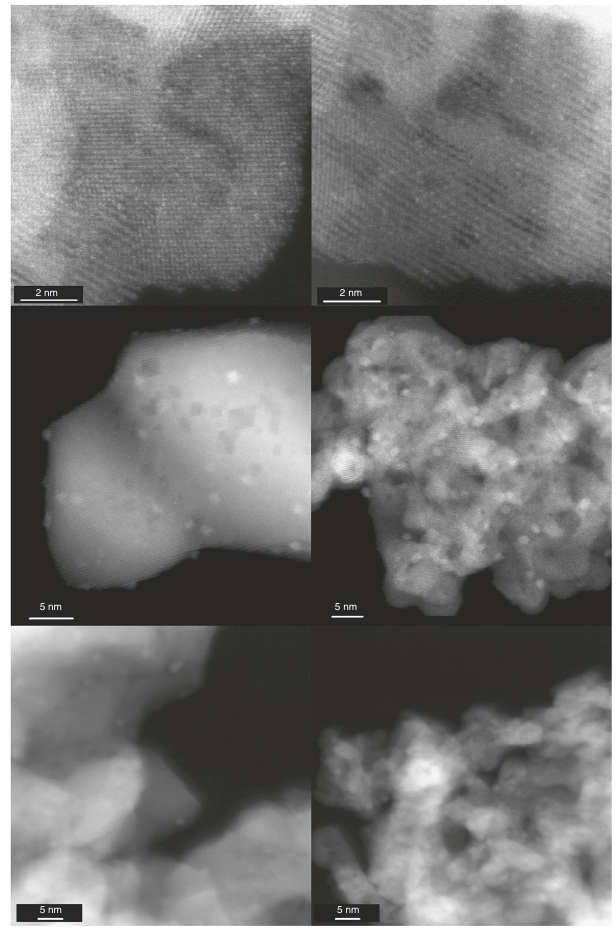
Fig. 2 HAADF-STEM images of the 1wt.% Pt/CeO 2 catalysts: a as- synthesized AT (CPA), b as-synthesized SEA (CPA), c activated AT (CPA), d activated SEA (CPA), e activated AT (TAPN), f activated SEA